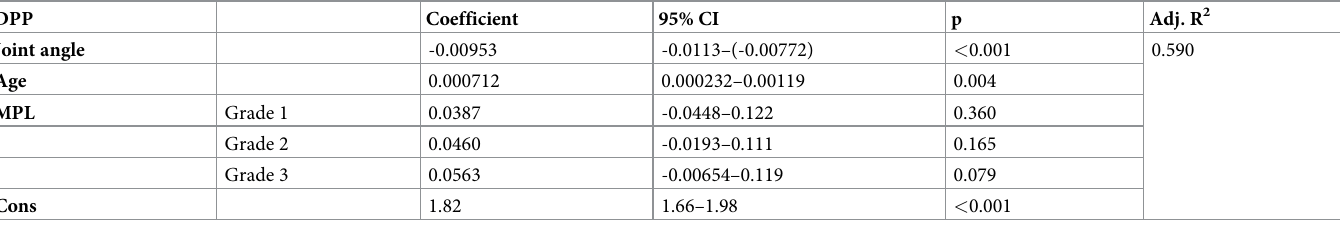
Table 6. Final models of multivariable linear regression analyses for DPP and the grade of MPL.